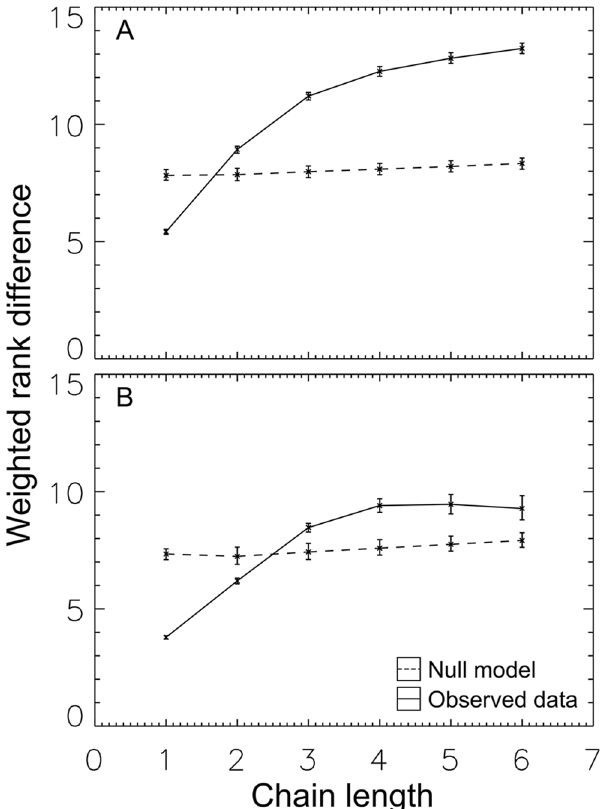
Fig 4. Cognitively-accessible social properties. Shown is the weighted average rank difference for different aggression chain lengths ( W ( n ), Eq 4) for Group One (a) and Group Two (b). The solid line shows the observed signal, while the dashed line shows that found in the null, with 1 σ error ranges. Significant evidence exists for a strong signal of relative rank contained in aggression chains. Such signals are then accessible to individuals capable of transitive